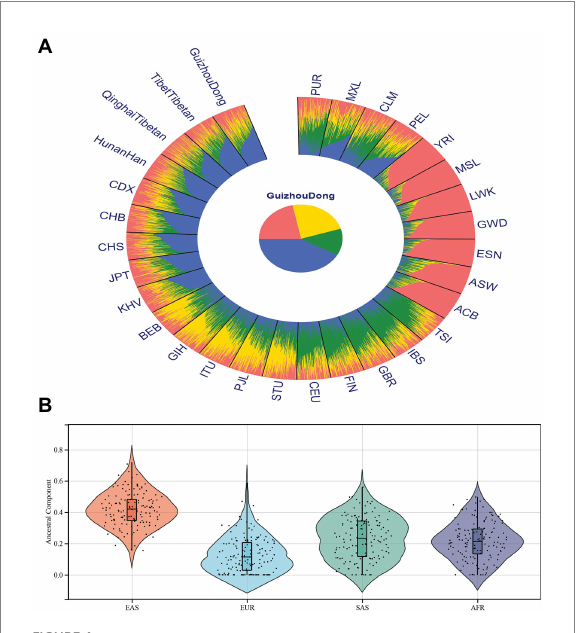
FIGURE 4 Ancestral component analyses of the Guizhou Dong group in comparison to other reference populations. (A) Population genetic structure of the Guizhou Dong group and other reference populations at K = 4; (B) Ancestral component proportions of the Guizhou Dong group from different continental